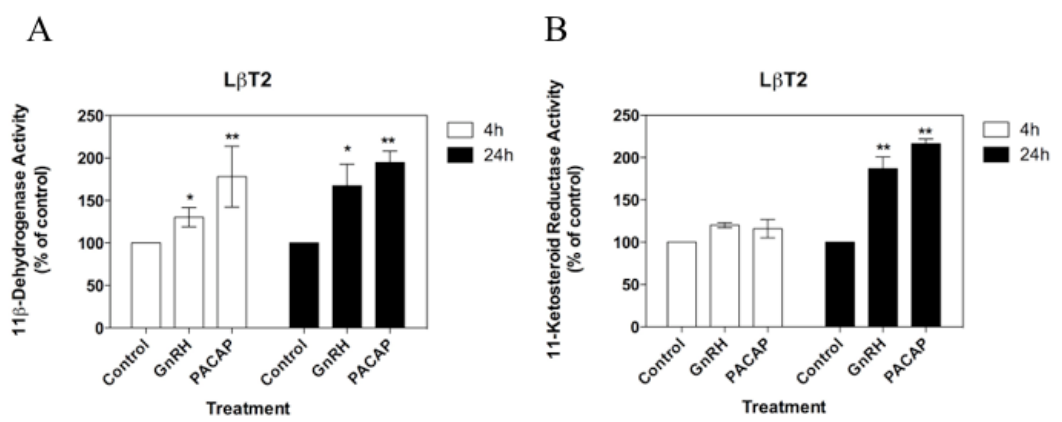
Figure 4. E ff ects of GnRH and PACAP on ( A ) 11 β -dehydrogenase and ( B ) 11-ketosteroid reductase activities in L β T2 cells over 4 h and 24 h using 100 nM [ 3 H]-cortisol and 100 nM [ 3 H]-cortisone as enzyme substrates. Values are mean ± SEM for three di ff erent cell passages (with triplicate measures in each passage). For each time point and enzyme activity, * p < 0.05 and ** p < 0.01 versus corresponding control. Data shown are normalised as a percentage of the corresponding control enzyme activity in the absence of treatments (ranging from 2.4 to 4.5 pmol product / 4 h for 11 β -dehydrogenase activity, and from 5.4 to 7.2 pmol product / 4 h for 11-ketosteroid reductase activity). Non-normalised data